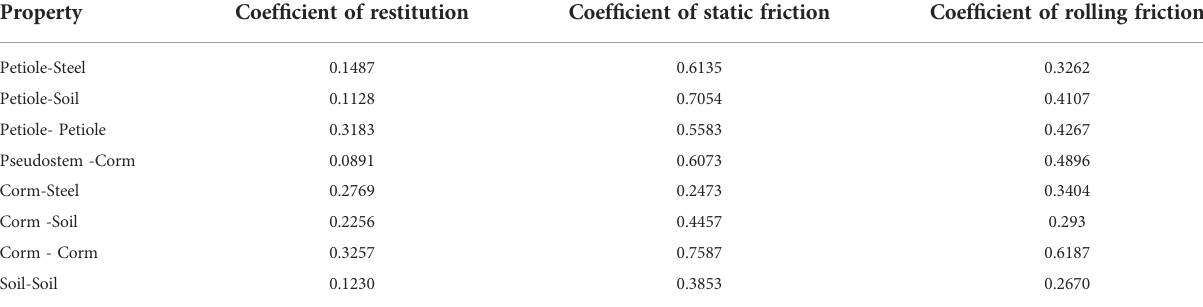
TABLE 2 Contact